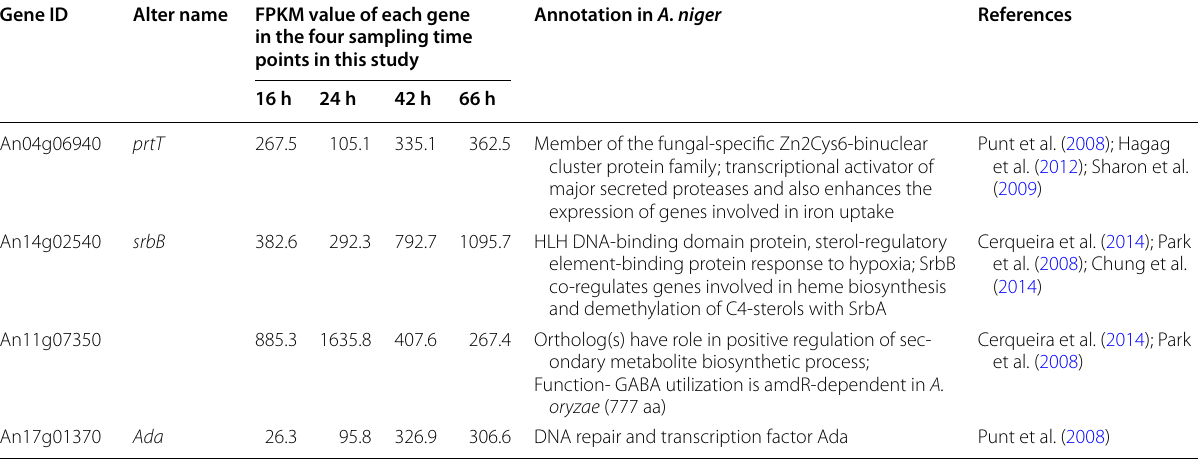
Table 4 Summary of important up-regulated transcription factors in the process of glucoamylase